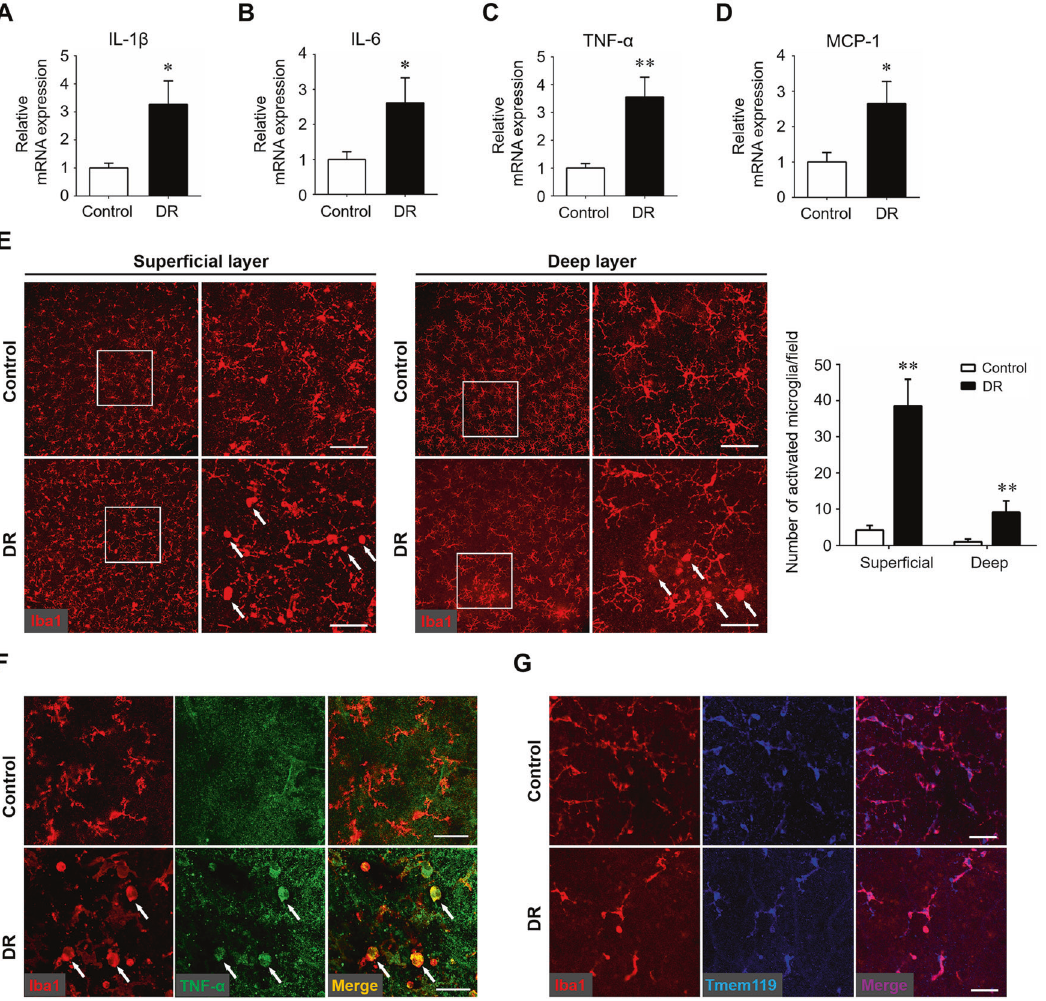
Fig. 1 Microglial activation and neuroin fl ammation cascade in the early stages of diabetic retinopathy. Streptozotocin-induced diabetes model was established and retina samples were collected 12 weeks after diabetes induction. Age-matched non-diabetes mice were used as control. A – D qRT-PCR array was carried out for several in fl ammation-related genes, including IL-1 β ( A ), IL-6 ( B ), TNF- α ( C ), and MCP-1 ( D ). Data were shown as mean ± S.D. The experiments were repeated 3 times for statistical analysis. E Representative images of iba-1 immunostaining on retinal fl at-mounts. Arrows indicated activated microglia characterized by swollen cell bodies and short branched processes. Scale bar: 50 μ m. Three images were obtained in different locations of the retina (central, mid-peripheral and peripheral areas) and 6 retinas from 6 mice in each group were used for analysis. F Immunostaining of iba1 and TNF- α on retinal fl at-mounts. Arrows indicated cells co-stained with both iba1 and TNF- α . Scale bar: 50 μ m. G Immunostaining of iba1 and Tmem119 on retinal fl at-mounts. Scale bar: 50 μ m. * P < 0.05, ** P <